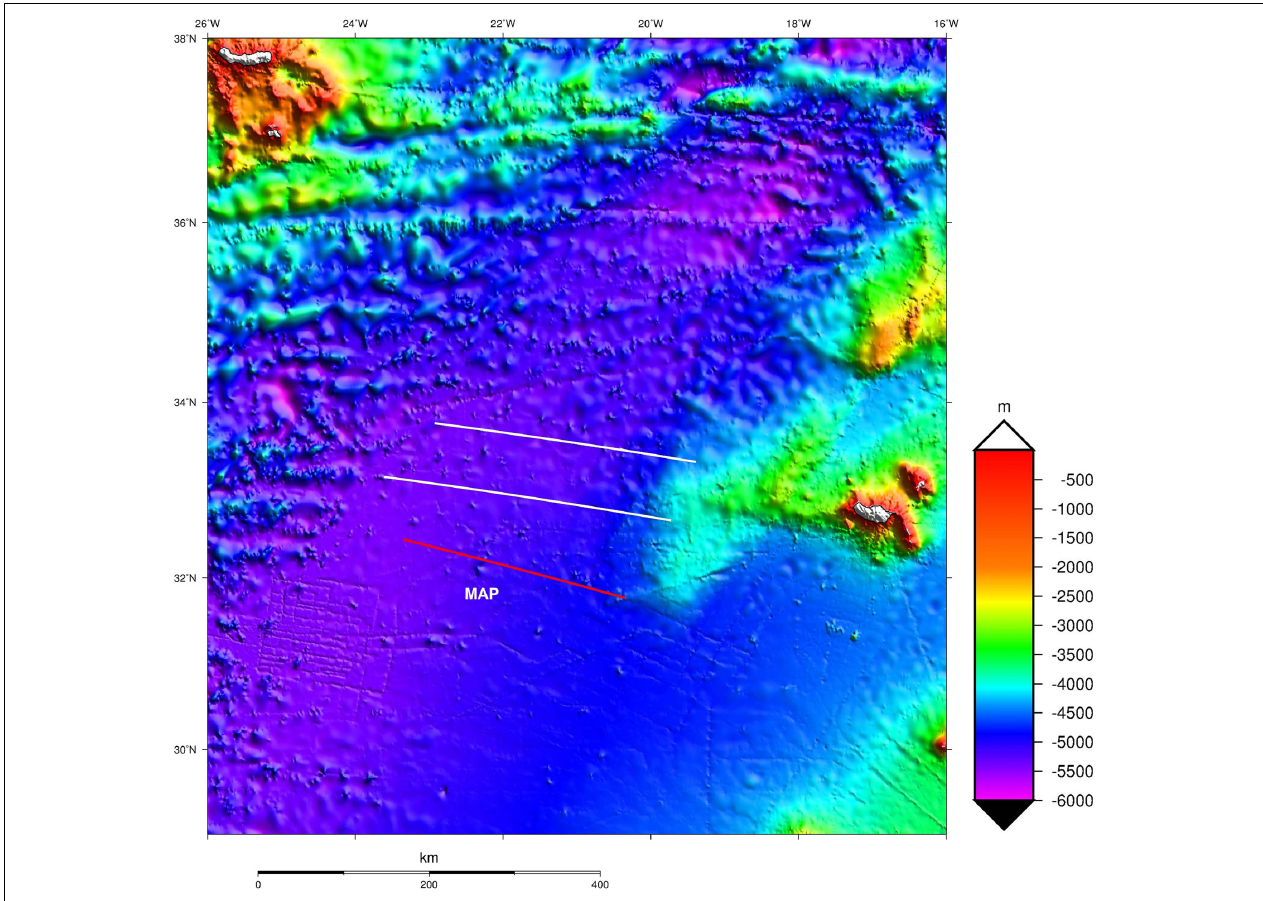
FIGURE 2 | Location of the MAP. The red line shows the location of the SO profile inverted with the proposed method. White lines correspond to other MCS profiles acquired under the same seismic acquisition survey.